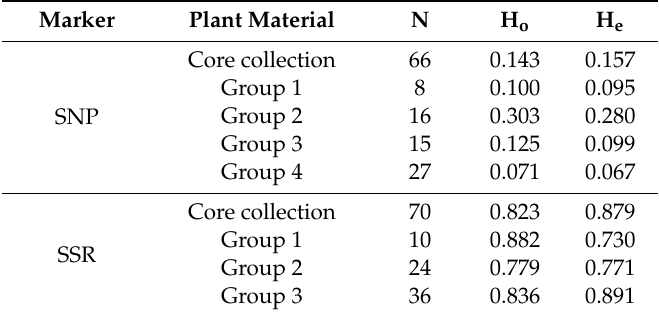
Table 2. Observed (H o ) and expected (H e ) heterozygosity of the vine rootstock core collection and the ancestral groups identified by the structure analysis based on SNP and SSR profiles. N = number of genotypes.